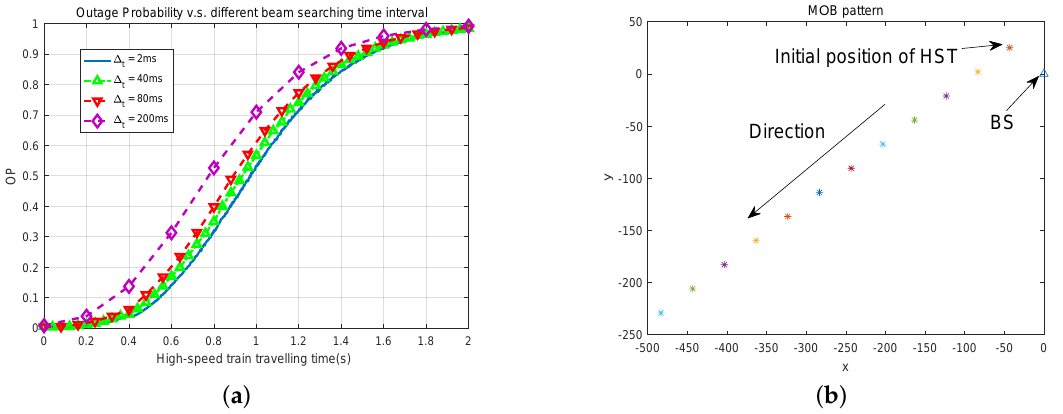
Figure 3. The influence of different beam-searching time interval and MOB pattern. ( a ) Effect of beam-searching time interval on OP; ( b ) Location and MOB pattern.